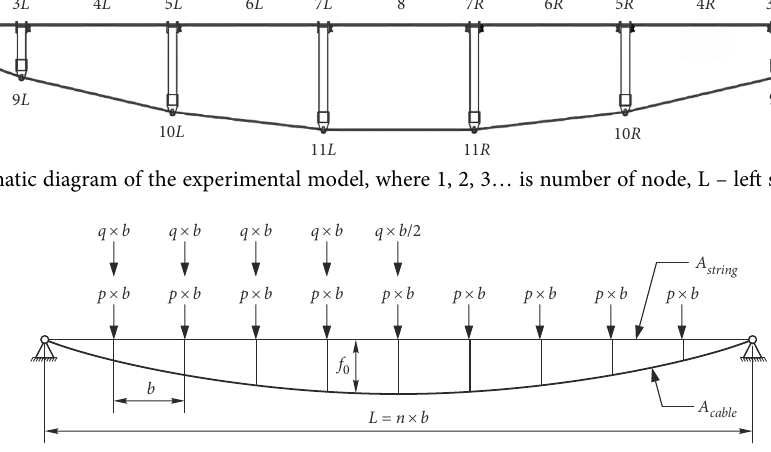
Figure 5. The principle of the model loading scheme, loading the structure with concentrated loads. Here b – the width of the internode; p – dead load Load per linear meter, q – live load Load per